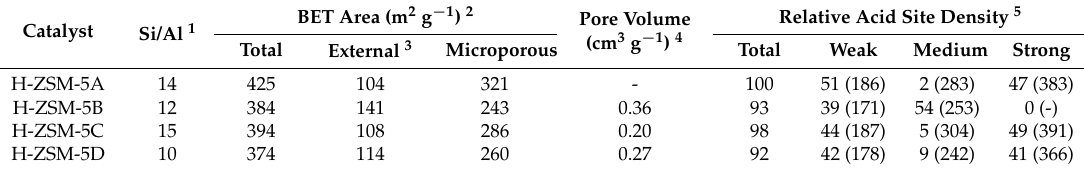
Table 1. Physicochemical properties of parent and modified H-ZSM-5 catalysts.